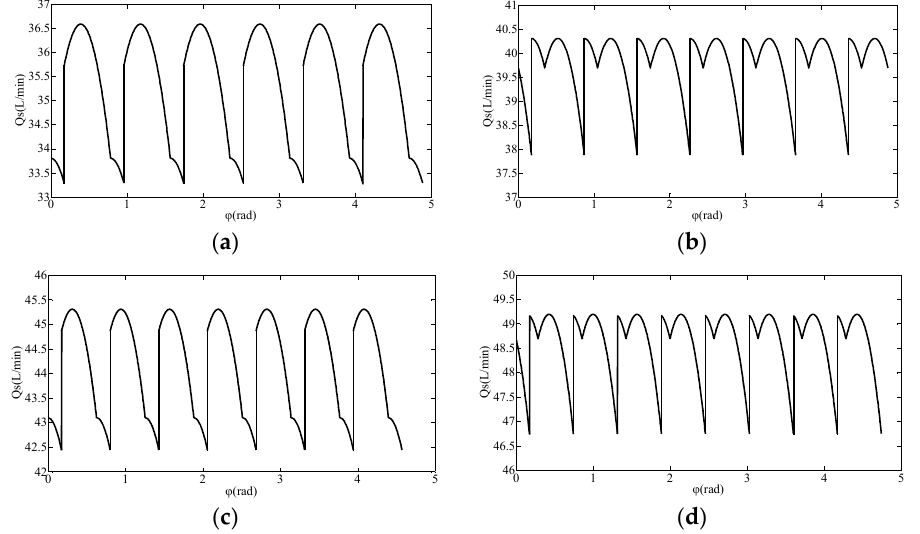
Figure 7. Actual output flow rate of piston pumps with 8~11 pistons for Δφ /2 = φ 0 = 5°. ( a ) output flow of 8-plunger pump; ( b ) output flow of 9-plunger pump; ( c ) output flow of 10-plunger pump; ( d ) output flow of 11-plunger pump.